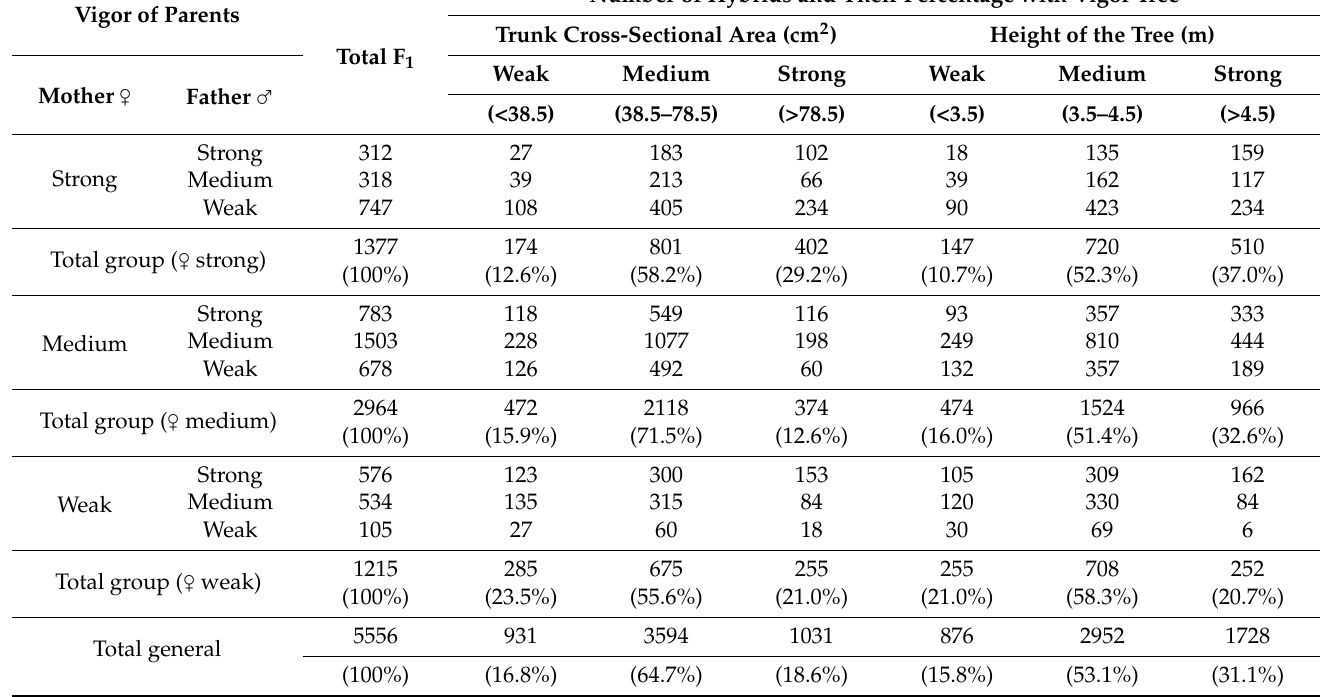
Table 2. Classification of F 1 hybrids from all hybridizations into three vigor classes depending on the trunk cross-sectional area—TCSA (cm 2 ) and tree height